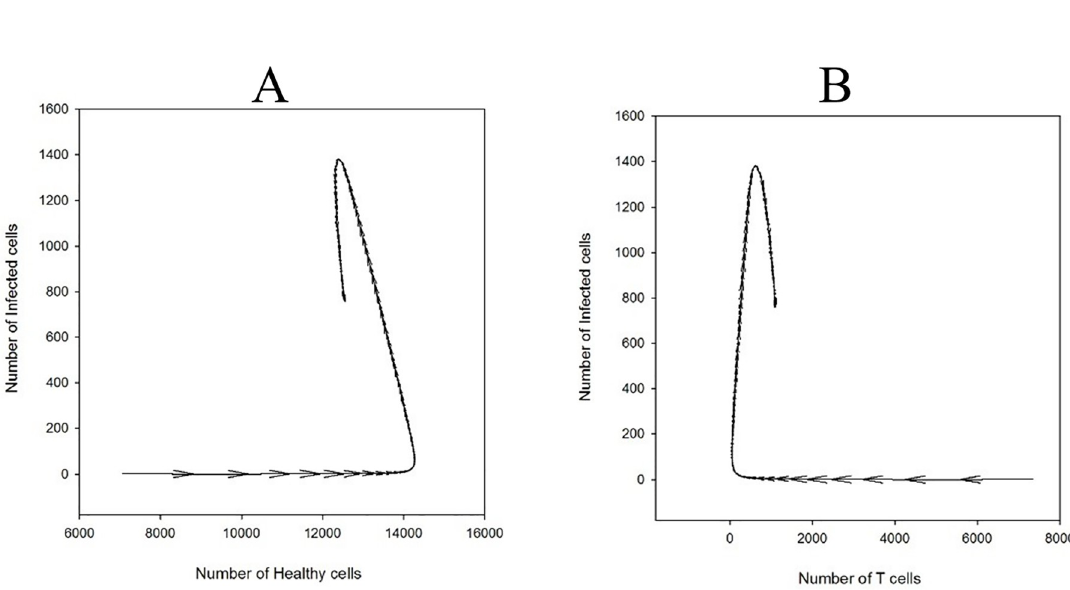
Fig 5. Total number of different cell types as a vector graph for the case of P I = 0.4, P T = 0.6, P H = 0.4, and P D = 0.24. Vector direction shows temporal evolution while vector magnitude demonstrates variation amount: A) The number of infected versus the number of healthy cells, B) The number of infected versus the number of T cells.